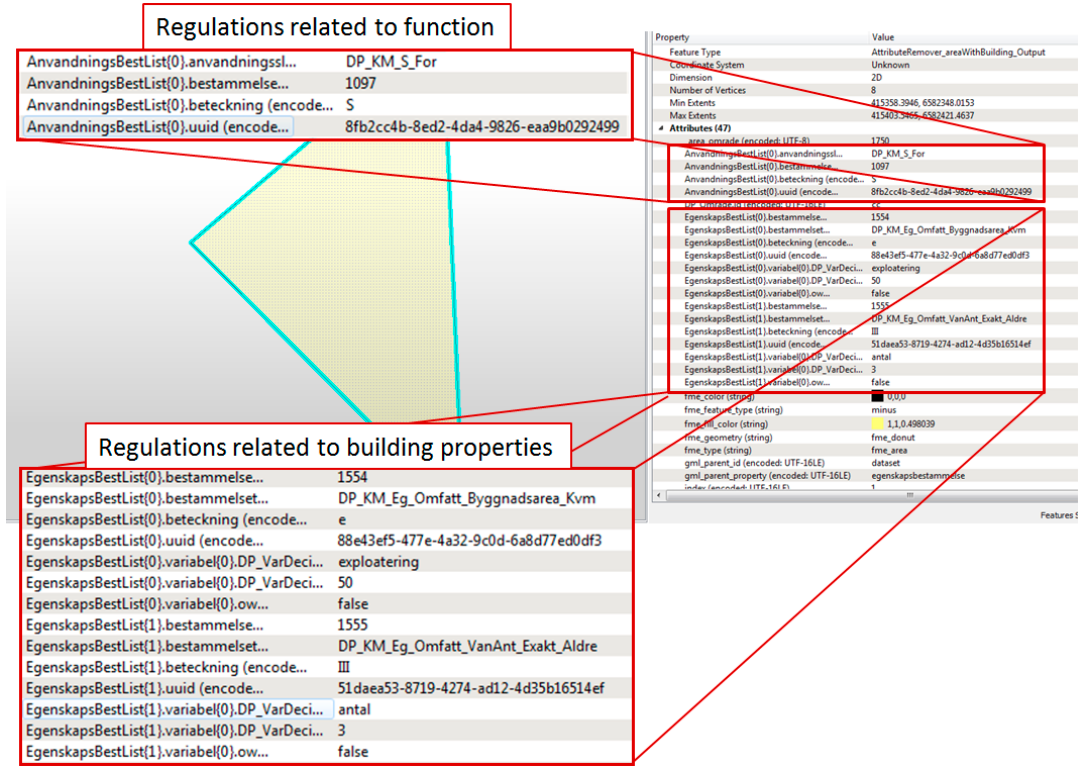
Figure 13. The existing regulations in the area where the building will be located according to the building permit application.